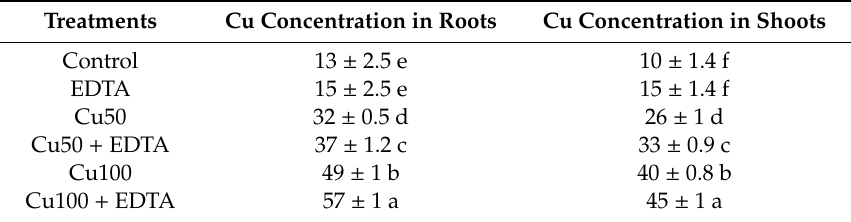
Table 2. Effect of different concentrations of Cu and with or without the application of EDTA on Cu Table 2. E ff ect of di ff erent concentrations of Cu and with or without the application of EDTA on Cu accumulation in roots (mg/g FW) and shoots (mg/g FW) of C. capsularis seedlings. accumulation in roots (mg / g FW) and shoots (mg / g FW) of C. capsularis seedlings. Treatments Cu Concentration in Roots Cu Concentration in Shoots Control 13 ± 2.5 e 10 ± 1.4 f Treatments Cu Concentration in Roots Cu Concentration in Shoots EDTA 15 ± 2.5 e 15 ± 1.4 f Control 13 ± 2.5 e 10 ± 1.4 f Cu50 32 ± 0.5 d 26 ± 1 d EDTA 15 ± 2.5 e 15 ± 1.4 f Cu50+EDTA 37 ± 1.2 c 33 ± 0.9 c Cu50 32 ± 0.5 d 26 ± 1 d Cu100 49 ± 1 b 40 ± 0.8 b Cu50 + EDTA 37 ± 1.2 c 33 ± 0.9 c Cu100+EDTA 57 ± 1 a Cu100 49 ± 1 b 40 ± 0.8 b Cu100 + EDTA 57 ± 1 a 45 ± 1 a